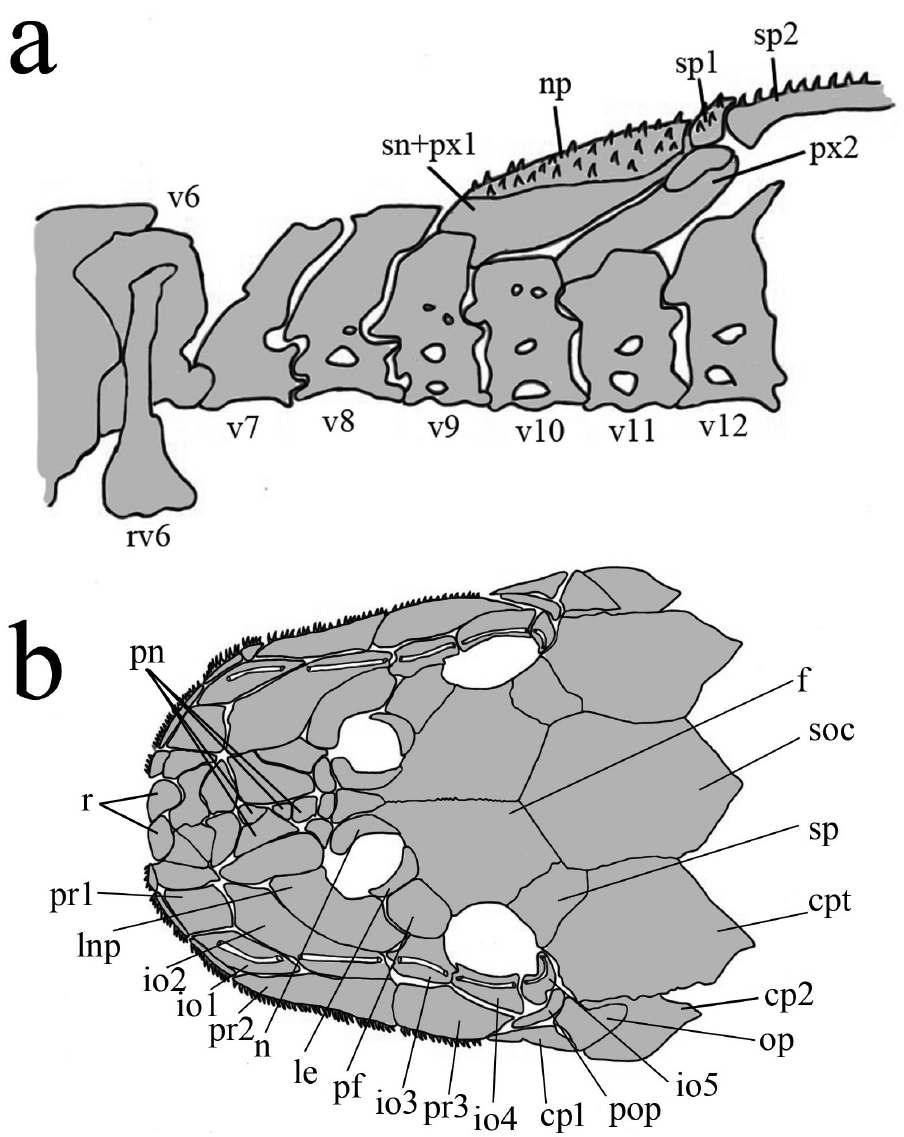
Figure 2. Rhinolekos capetinga , LBP 19001, paratype, 34.5 mm SL. a Anterior portion of axial skeleton and dorsal-fin supports (left side, lateral view). Vertebrae counts included five vertebrae of the Webe- rian apparatus. np nucal plate; rv6 rib of sixth vertebrae; px2 compound proximal and medial radial 2; sn+px1 compound supraneural first dorsal-fin proximal radial; sp1 first dorsal-fin spinelet; sp2 second dorsal-fin spine; v6−12 vertebrae 6−12 b Skull of R. capetinga ; f frontal; soc supraoccipital; cpt parieto- supraoccipital; op opercle; io1−5 infraorbitals; pop preopercle; cp 1−2 cheek plates; pr 1−3 postrostral plates; pf prefrontal plates; le lateral ethmoid; n nasal; lpn lateronasal plate; r rostral plate; pn prenasal; sp